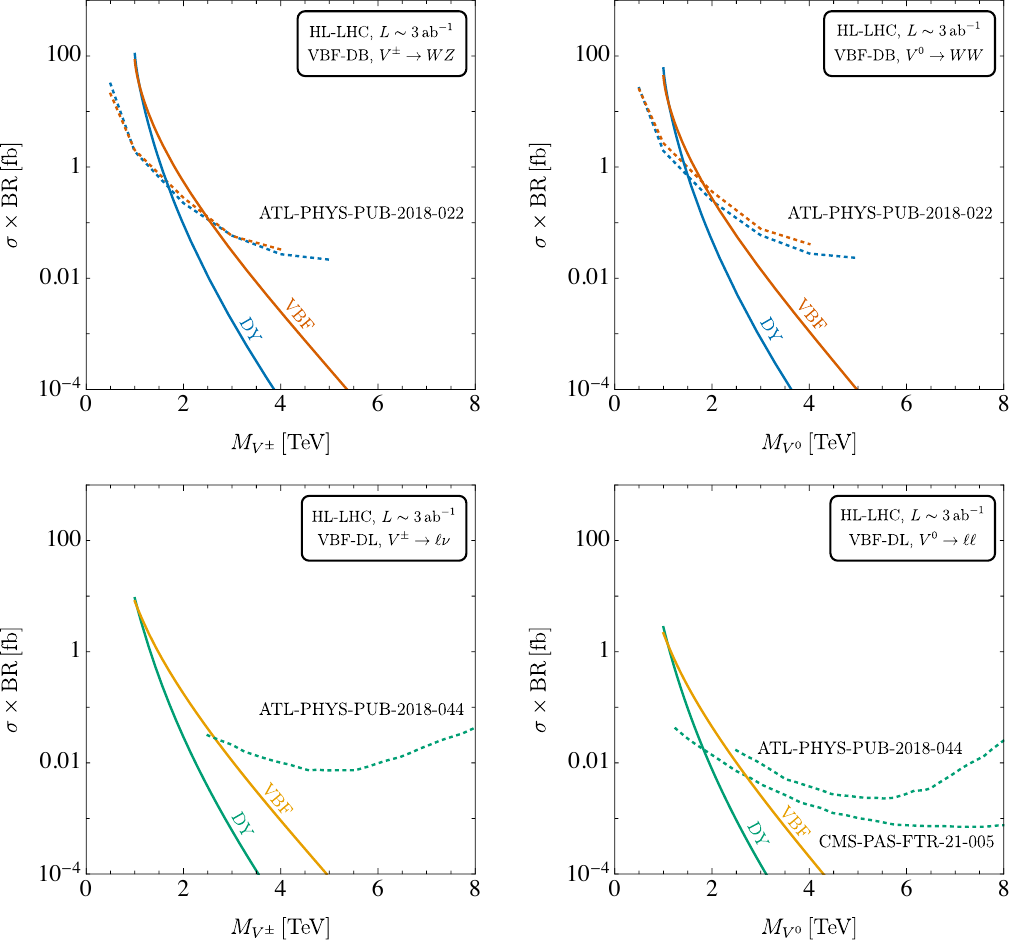
Figure 7 . (Top) Production cross-section times branching ratio in WZ (left) and WW (right) for the VBF di-boson benchmark for DY and VBF production in blue and red, respectively. Projections for the HL-LHC limits at 14 TeV with 3 ab − 1 [38] are shown in dotted blue (DY) and dotted red (VBF). (Bottom) Production cross-section times branching ratio in ‘ν (left) and ‘‘ (right) for the VBF di-lepton benchmark for DY production and VBF in green and yellow, respectively. Projections of HL-LHC limits at 14 TeV with 3 ab − 1 [53, 54] are shown in dotted green